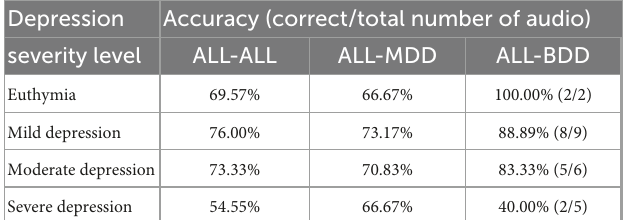
TABLE 3 Performance of MGMT in four-level depression severity classification of three test